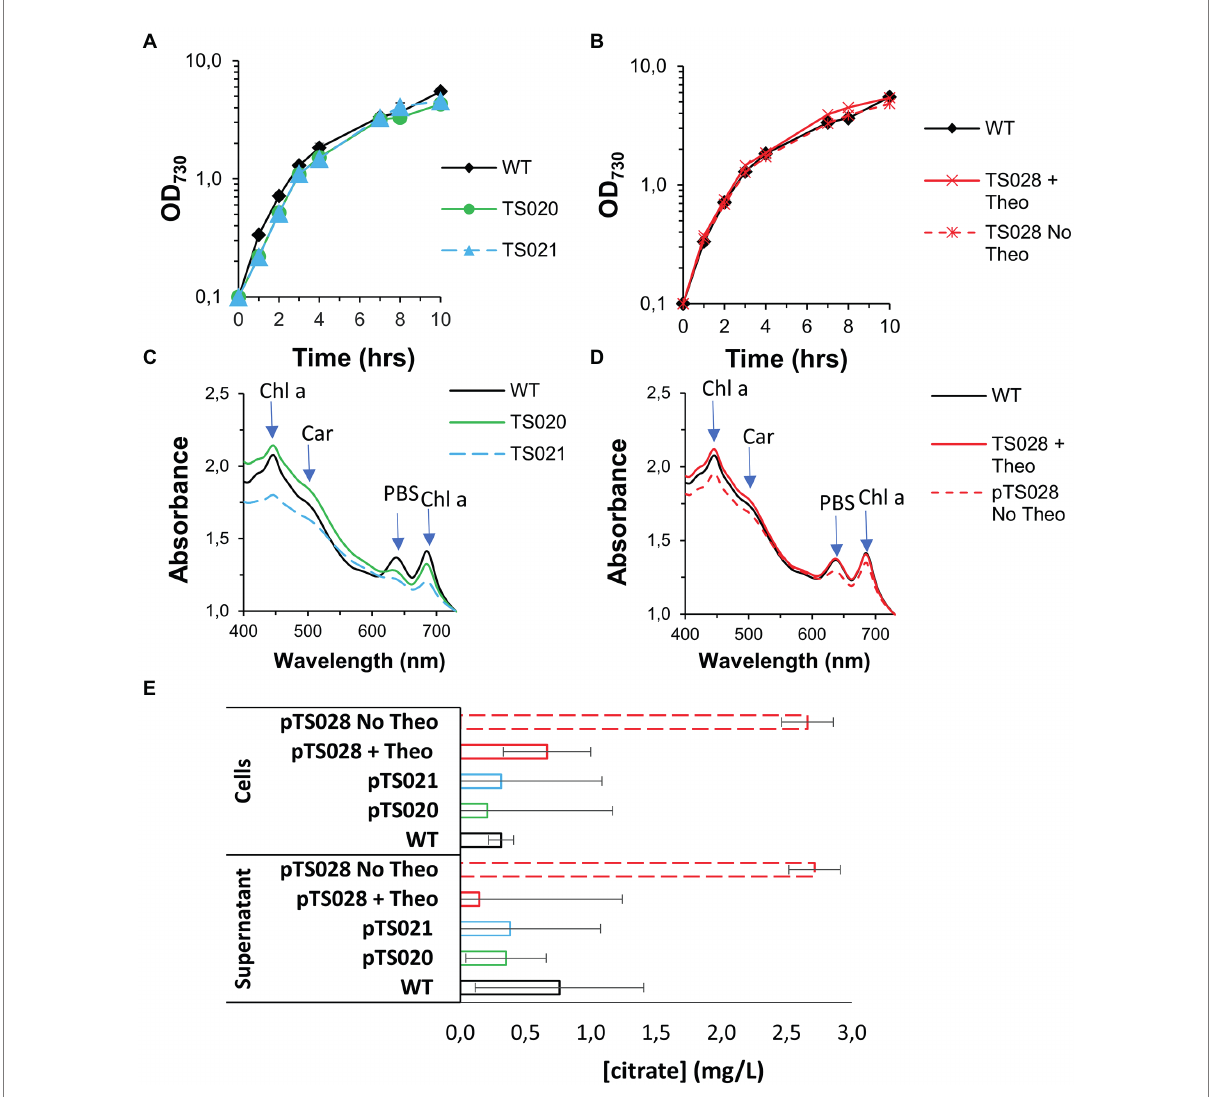
FIGURE 3 Growth curves and citrate quantification in AD7, air, low light conditions. (A) Growth curves for two citrate synthase overexpression strains. (B) Growth curves for strain TS028, without and with 2 mM theophylline (Theo) supplementation. (C) Whole cell spectra of WT, TS020 and TS021 at day 10. Arrows indicate absorbance maxima for chlorophyll a (Chl a), carotenoids (Car) and phycobilisomes (PBS). (D) Whole cell spectra of WT and TS028, without and with 2 mM Theo supplementation. (E) Citrate quantification in cell pellets and culture